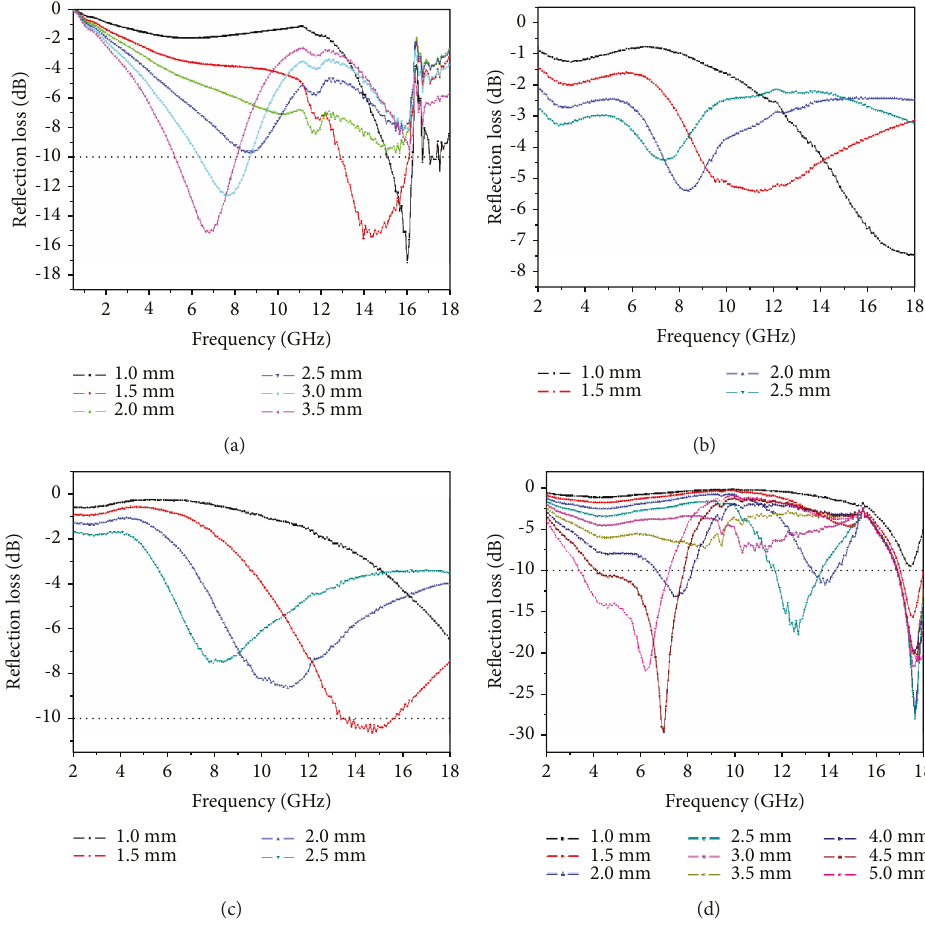
Figure 8: Re fl ection loss of Fe